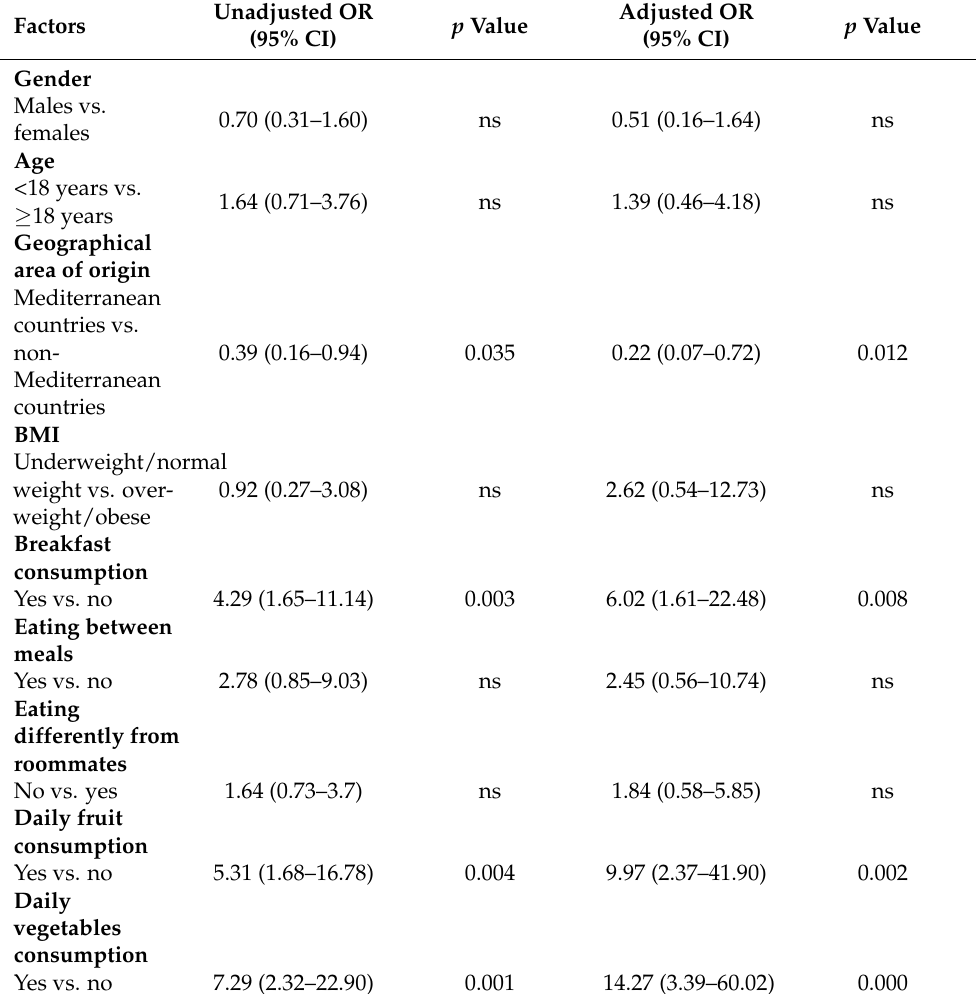
Table 10. Odds ratio (OR) and 95% confidence intervals (CI) from logistic regression analysis showing the association of adherence to the MD with selected lifestyle and dietary